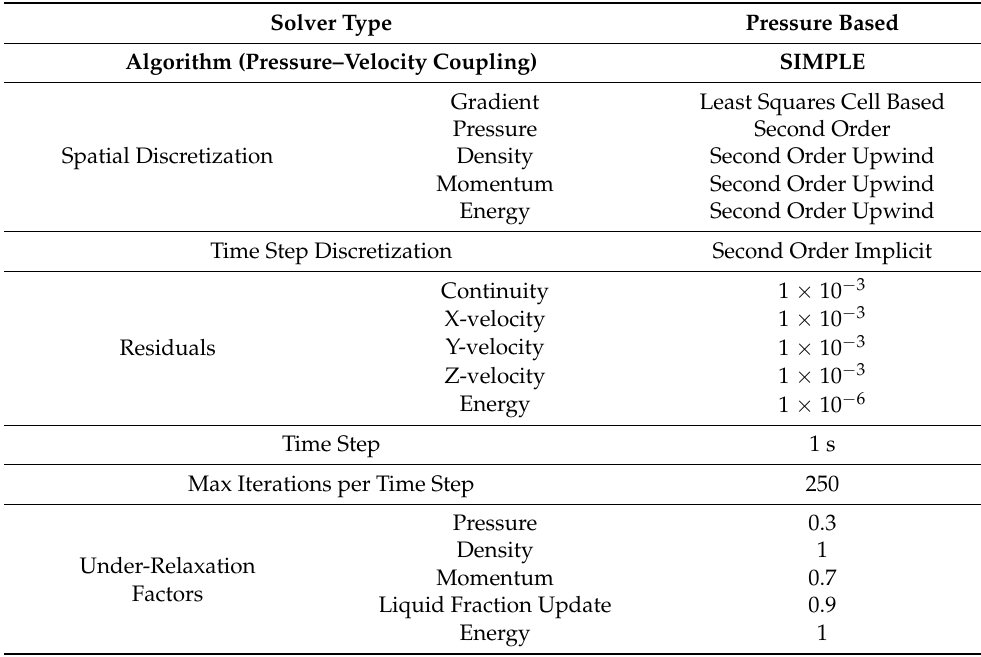
Table A1. Numerical model details